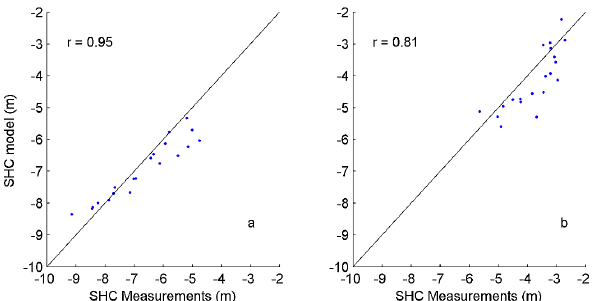
Fig. 5. Results of the leave-one-out cross-validation: measured vs. modeled annual surface height change for (a) year 1 (29 August 2006–21 August 2007) and (b) year 2 (21 August 2007–27 Au- gust 2008). Individual model parameter combinations for calculat- ing surface height change for each point were modeled using the best parameter combination evaluated for all other points (19) but not the considered one (Sect. 2.2.3).